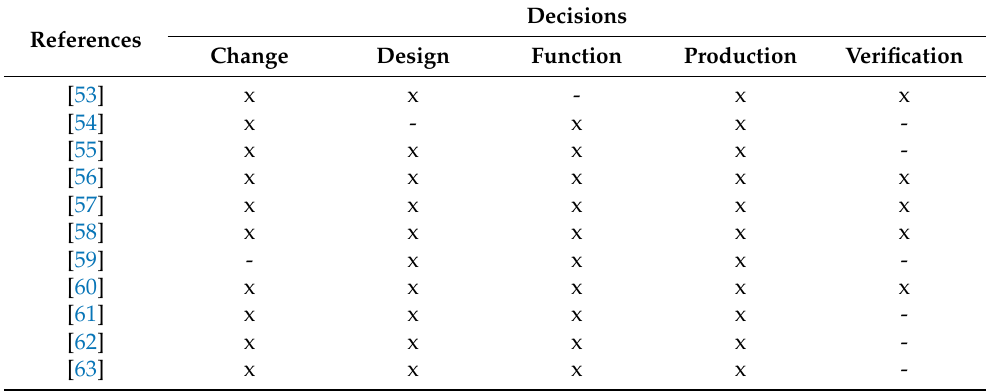
Table 2. The configuration decision key areas that the found literature